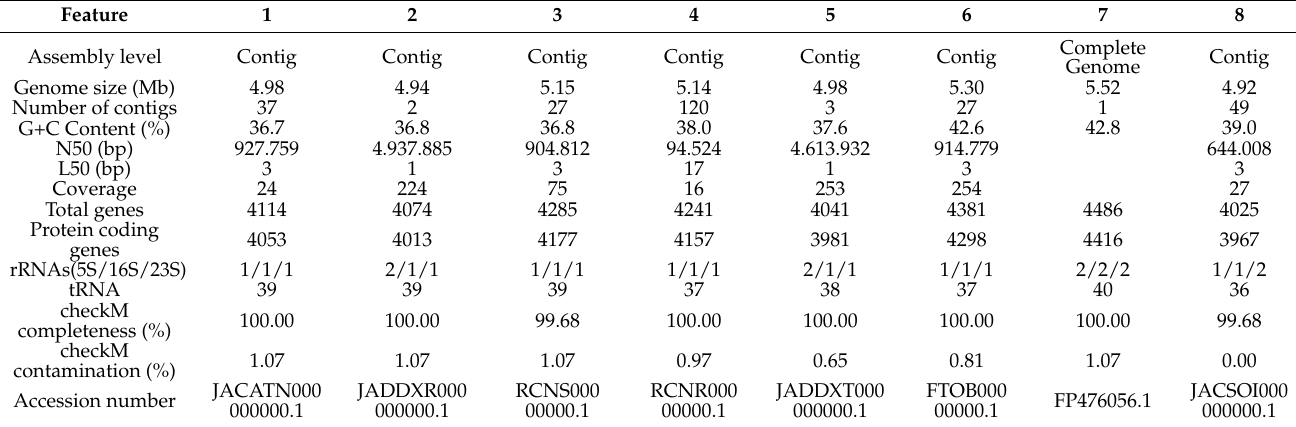
Table 1. General genomic features of the strain 36-CHABK-3-33 T and other species of the genus Zobellia